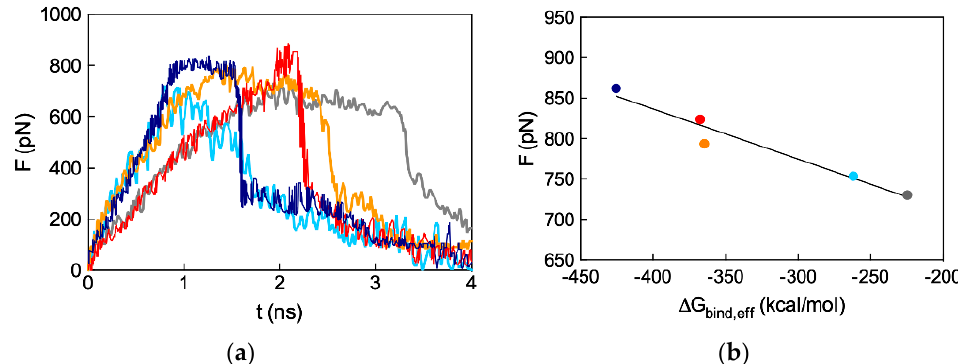
Figure 14. ( a ) Profiles of the average force required to unbind ssiRNAs from their G 5 TEA-core dendrimer nanovectors as obtained from steered molecular dynamics (SMD) simulations. Color legend: Dark blue, (T 7 / T 7 ) ssiRNA; light blue, (T 5 / T 5 ) ssiRNA; gray, (T 2 / T 2 ) (i.e., non-sticky) siRNA; red, (A 7 / A 7 ) ssiRNA; orange, (A 5 / A 5 ) ssiRNA. ( b ) Relationship between the SMD peak force and the corresponding effective free energy of binding Δ G bind,eff for the corresponding ssiRNA and the G 5 dendrimers. Redrawn from [57], with permission of the American Chemical Society.